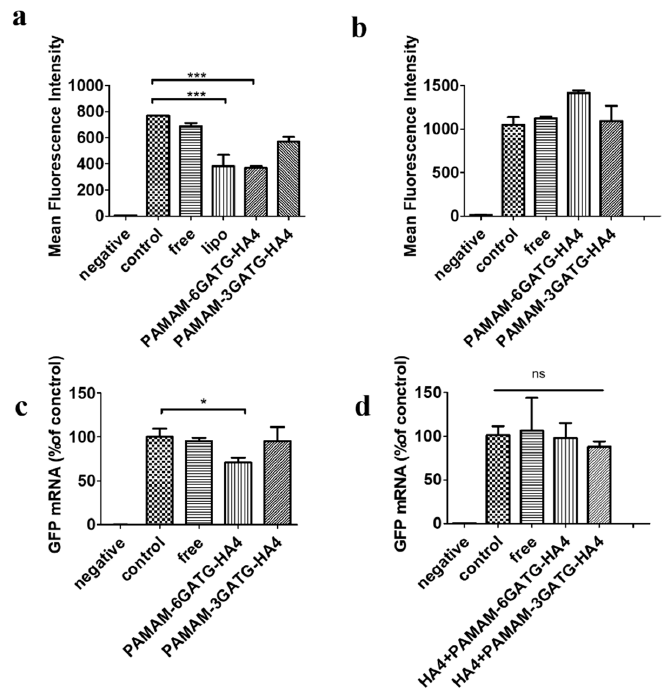
Figure 4. The gene silencing efficacy of PAMAM-GATG-HA4 nanocomplexes analyzed by flow-cytometry and quantitative real-time polymerase chain reaction (qRT-PCR) in MDA-MB-231-GFP cells. The gene silencing efficacy without adding hyaluronan tetrasaccharide was analyzed ( a ) by flow-cytometry and ( b ) with adding hyaluronan tetrasaccharide analyzed by flow-cytometry. ( c ) The gene silencing efficacy without adding hyaluronan tetrasaccharide analyzed by qRT-PCR and ( d ) with adding hyaluronan tetrasaccharide analyzed by qRT-PCR. Statistical analysis was performed with one-way ANOVA and Bonferroni post-hoc testing with * p < 0.05 and *** p < 0.01. The “negative” represents the blank control group using MDA-MB-231 cells without GFP; the “control” means the MDA-MB-231-GFP cells were not treated with siGFP or nanocomplexes; and the “free” and “lipo” mean the MDA-MB-231-GFP cells were treated with free siGFP or lipofectamine 2000 containing siGFP respectively.